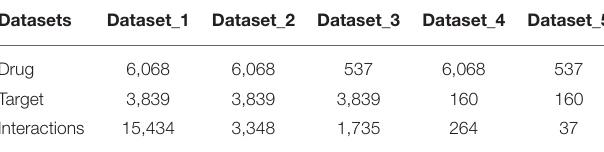
DrugBank dataset.